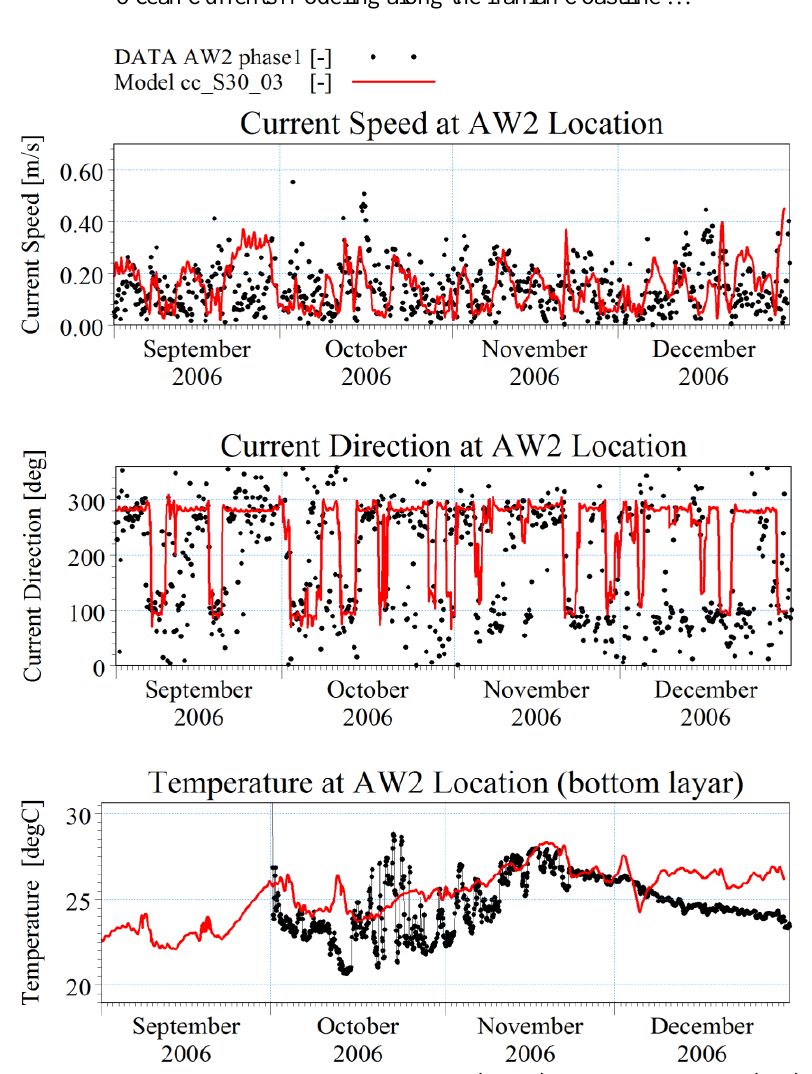
Figure 12. Comparisons between AW2 data (black) and model results